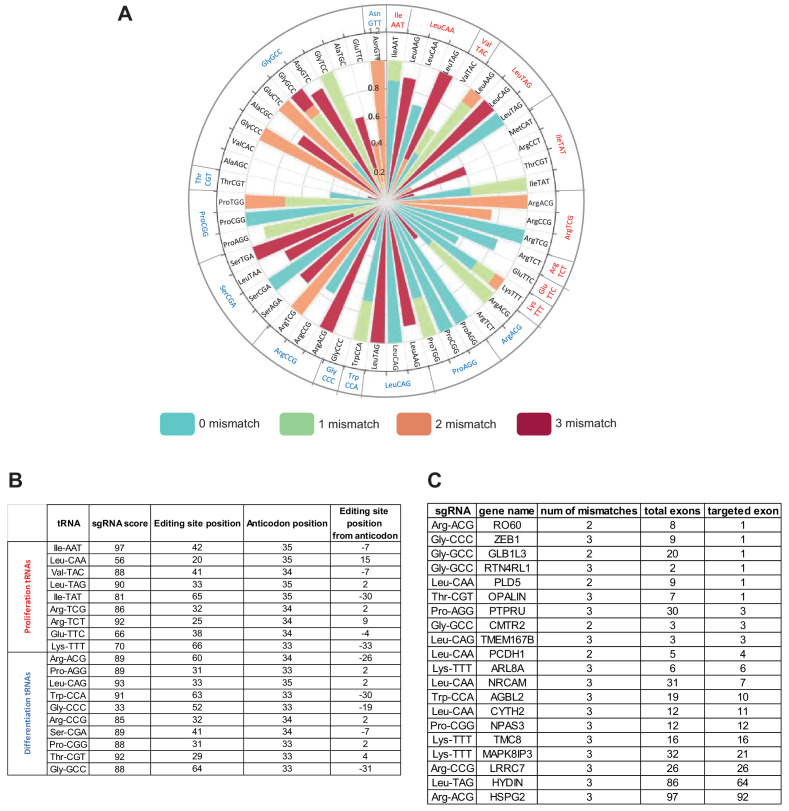
sgRNA targeting parameters and OFF-targets potential.(A) A rose chart representing the tRNA targets of the sgRNA library. For each sgRNA (presented in the outmost circle), the tRNA families that are considered as potential targets (both ON-targets and OFF-targets) are detailed in the middle circle. The bars in the innermost circle indicate, for each tRNA family, the fraction of genes with 0 mismatches (blue) one mismatch (green) two mismatches (orange) and three mismatches (Bordeaux). (B) A table representing various parameters of the sgRNA library. The sgRNA parameters include the score for each sgRNA as well as the editing position. The sgRNA score was determined using CHOP-CHOP, a CRISPR web toolbox (Montague et al., 2014). Also given information regarding the anticodon position and the distance between the editing site and the anticodon. (C) A table describing potential OFF-targets in protein coding genes. For each sgRNA, several parameters are mentioned for each OFF- target gene: the identity of the sgRNA, the OFF-target gene name, number of mismatches relative to the sgRNA sequence, total number of exons and the exon number in which the target site is located.